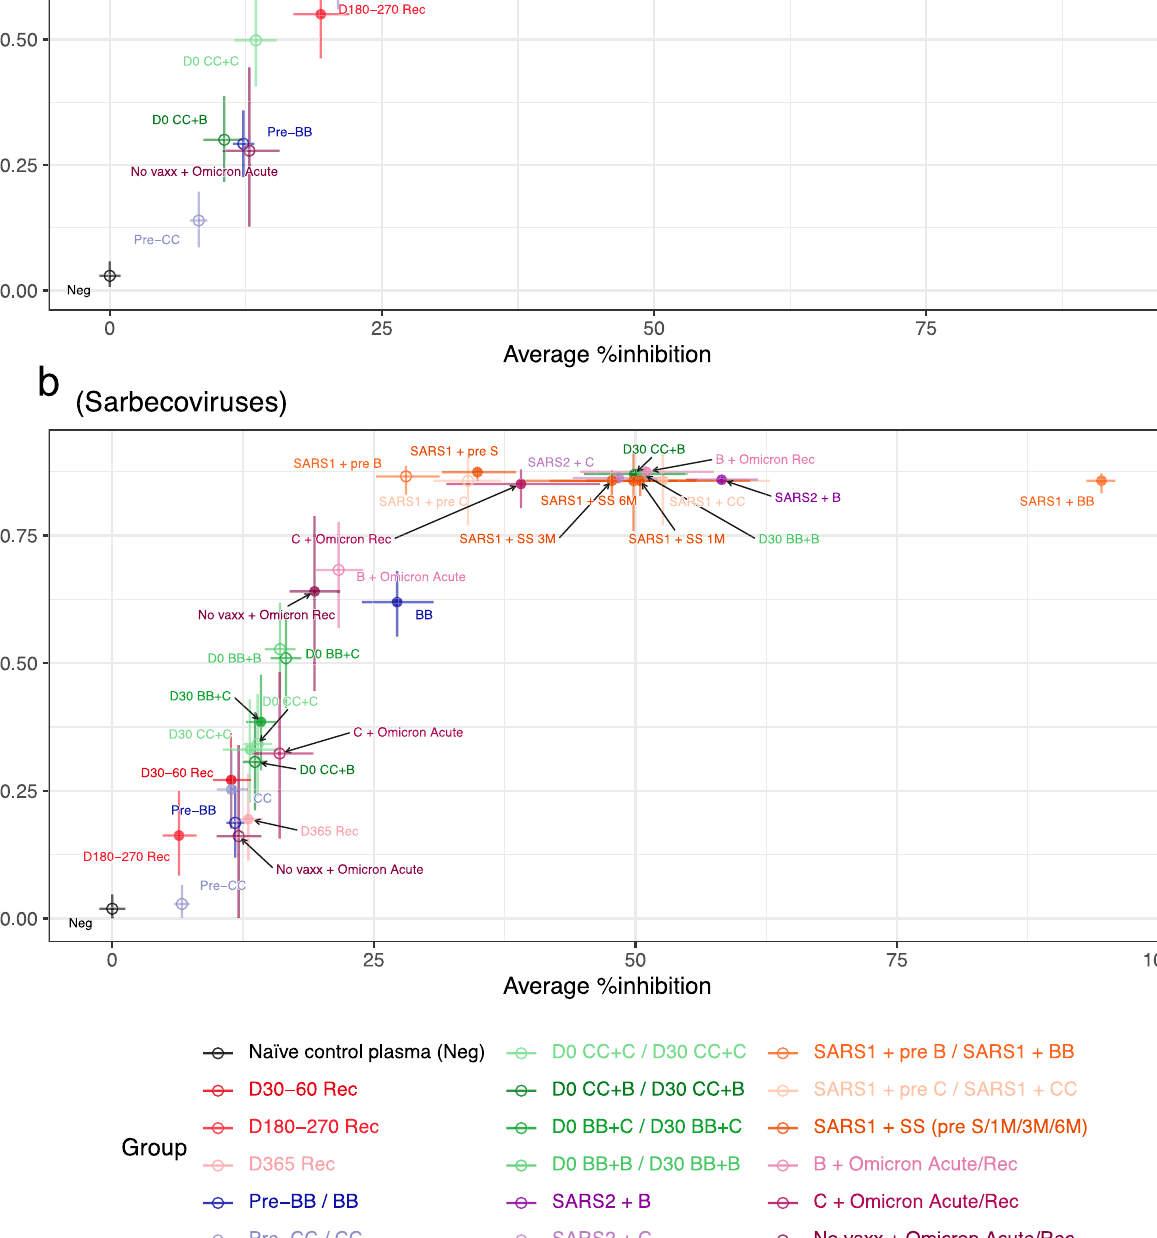
Fig. 5 | Overview of antigen diversity versus magnitude of neutralizing anti- body responses for SARS-CoV2 viruses and sarbecoviruses for different prim- ing conditions. A 2-D representation of all samples tested (from Table 1) for antigenic diversity versus the average % inhibition of all RBDs for SARS-COV-2 and itsVoC( a ),and allsarbecovirusestested ( b )fordifferentprimingconditions(from